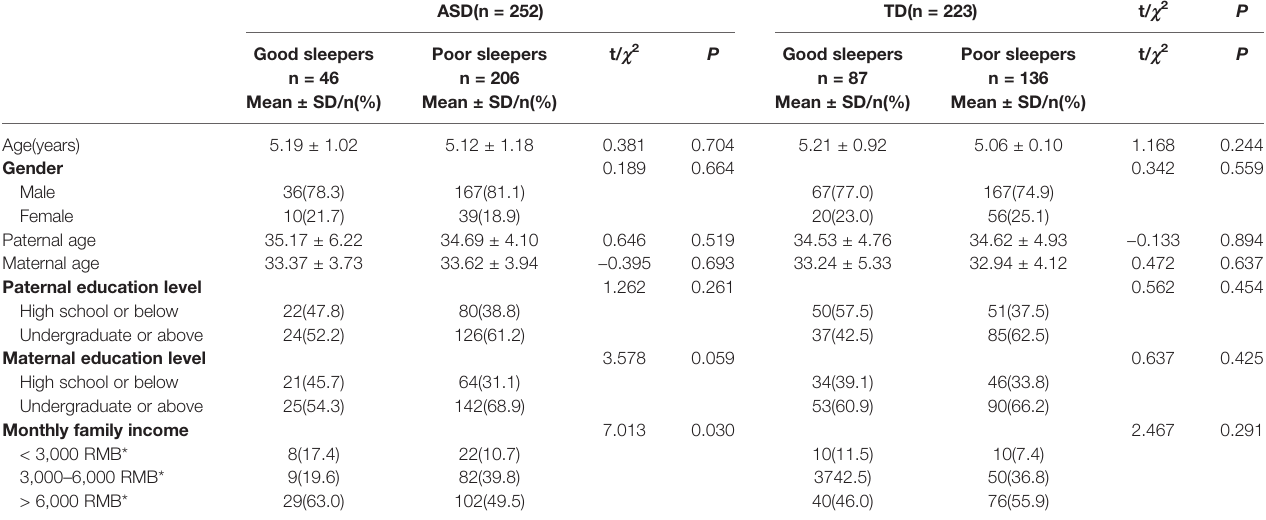
TABLE 3 | Sociodemographic characteristics of good sleepers compared to poor